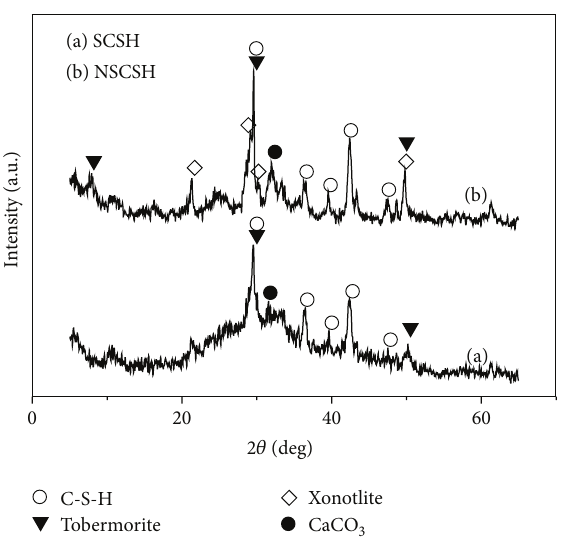
Figure 1: XRD patterns of (a) SCSH and (b)